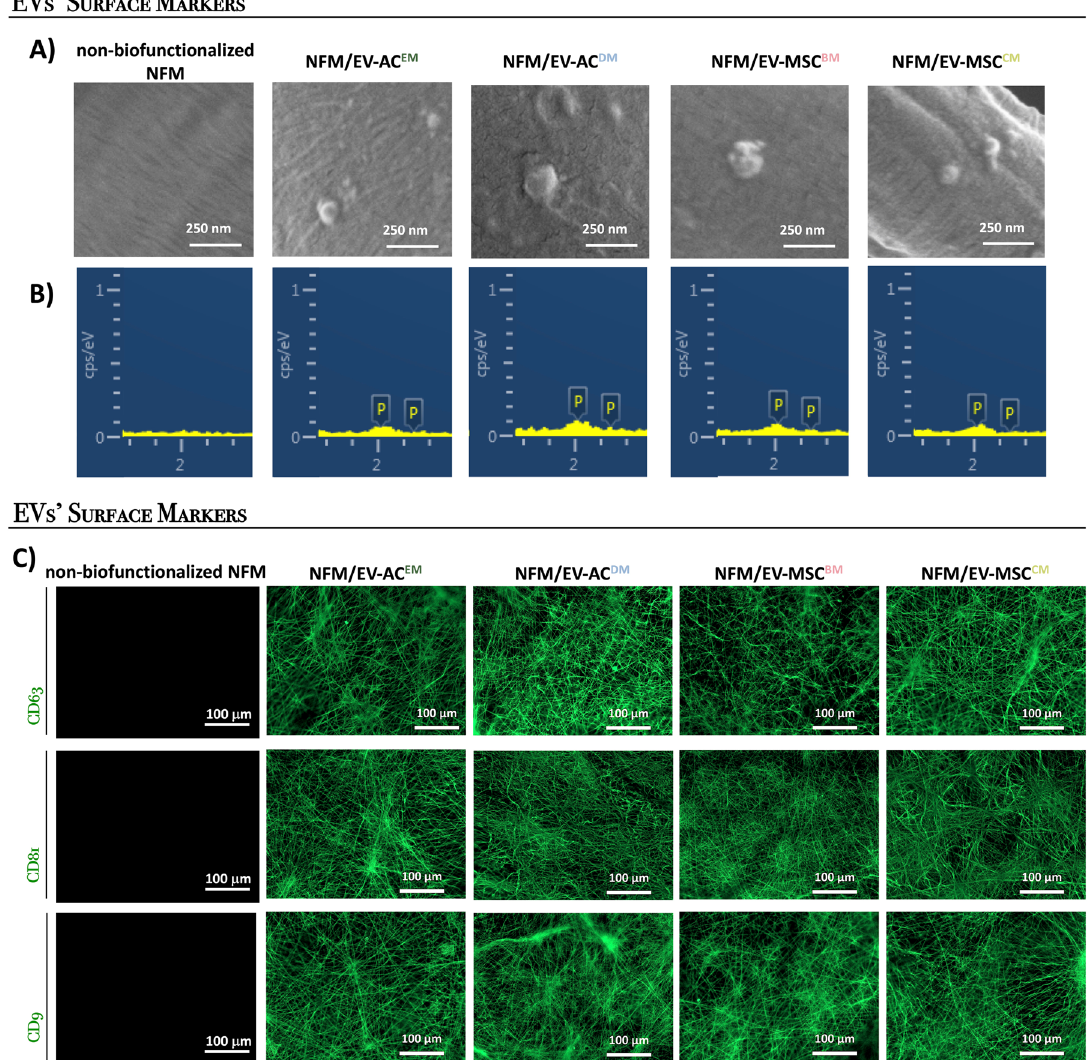
Fig. 2 Distribution of bound extracellular vesicles. Distribution of EVs bound at the surface of the biofunctional nano fi brous system ( A ); EDS spectrum of the EVs immobilization system surface ( B ); fl uorescence micrographs of the EVs markers CD63, CD81, and CD9 ( C